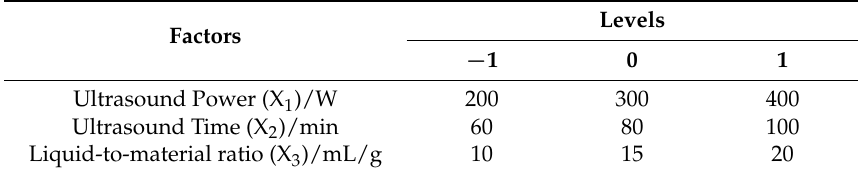
Table 4. Independent factor and their levels used in ultrasound-assisted extraction of